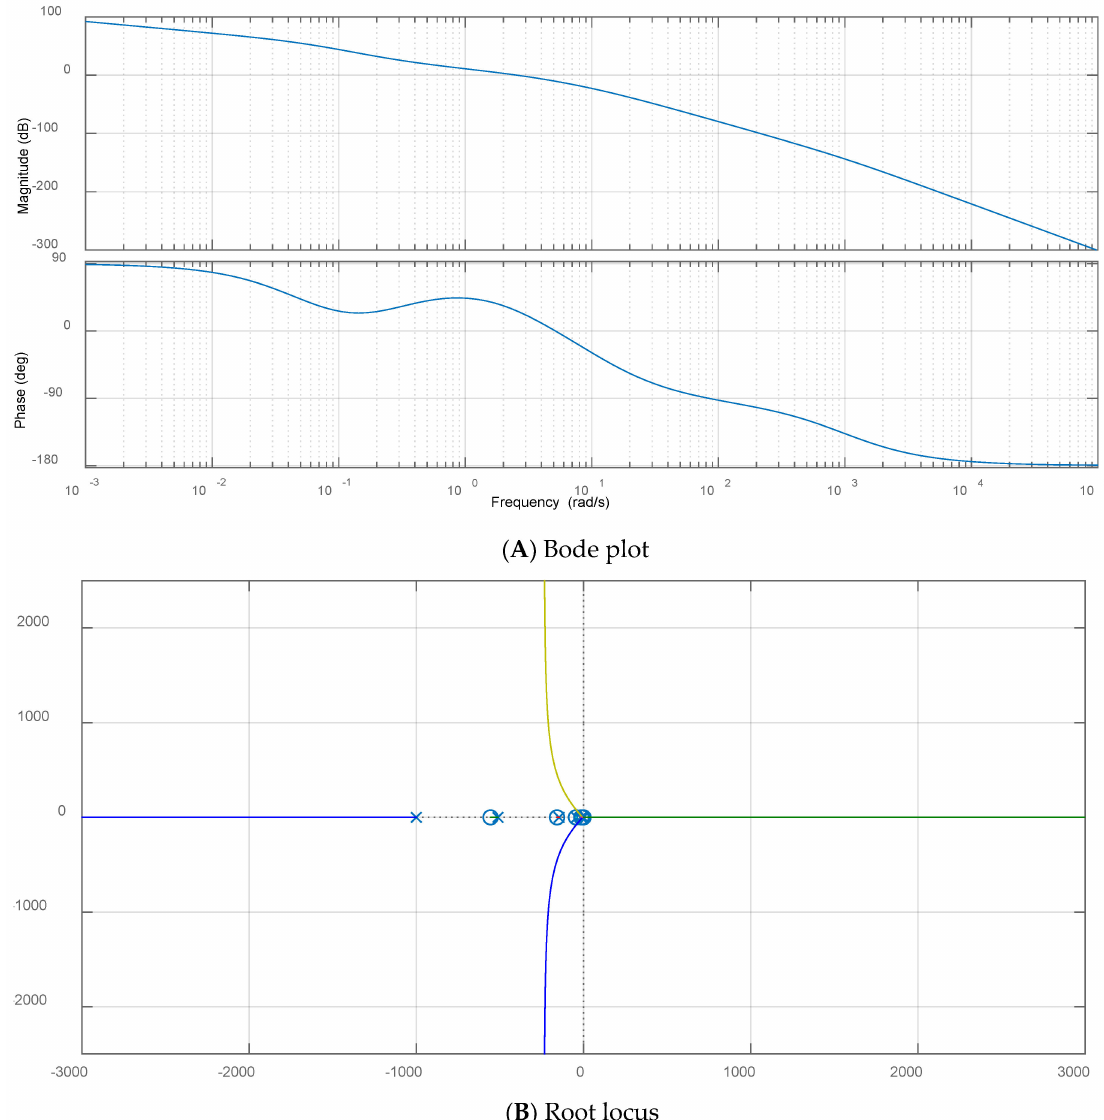
Figure 8. ( A , B ) Bode and root locus responses of the hybrid power